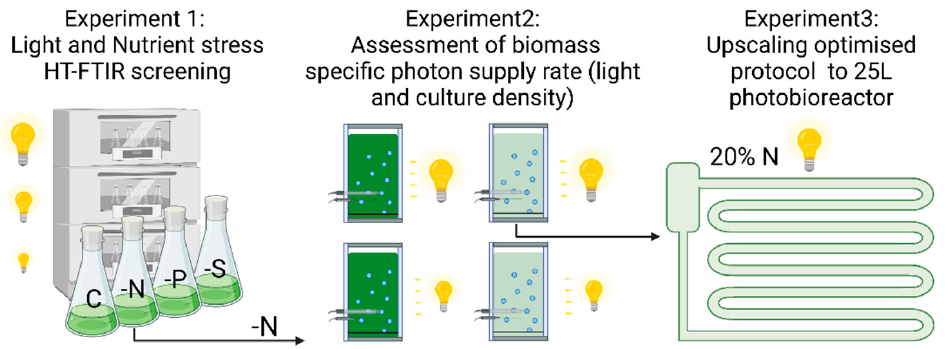
Figure 1. Experimental setup of the three experiments performed in the study. In experiment 1, FTIR spectroscopy screening, a Multitron Incubator with three cham- bers (InforsHT, Mainz, Germany) was used to test different cultivation conditions in 36 cultures. The experiment was performed in 1 L Erlenmeyer flasks containing 500 mL culture, mixed by filter-sterilised air with 1% CO 2 and orbital shaking at 110 rpm, and the light was provided from two sides. Twelve cultures with a starting Absorbance 750 nm = 1.2 were cultured for acclimation in full M8a medium, increasing light intensity from 100 to 400 µ mol m − 2 s − 1 . The starting pH was 7.5. After incubating for six days cultures were centrifuged and resuspended in 36 Erlenmeyer flasks at an Abs 750 nm = 0.5 in four medium treatments (control (C), nitrogen starved (-N), phosphorous starved (-P) and sulphur starved(-S) in triplicates. The temperature was set to 25 ◦ C and the three incubator chambers were set respectively at 800, 1300 and 1800 µ mol m − 2 s − 1 . tors [49] to study the effect of light intensity and culture density on the production of starch. The reactors’ volume capacity was 1.5 L and the light path 3 cm. The light was supplied by modulable LED panels, 5% CO 2 : air mixture ( v / v ) was supplied on demand to maintain pH stable at 7.5 ± 0.1 and the temperature was set at 25 ◦ C. Cultures were acclimated for four days, increasing light intensity daily from 100 to 500 µ mol m − 2 s − 1 . The cultures were harvested and centrifuged, and the algae were resuspended in a nitrogen starvation medium at the desired density and aliquoted into six reactors. Two inoculation densities, 0.25 and 0.65 g L − 1 were tested at two light intensities, 1300 and 1800 µ mol m − 2 s − 1 . Each treatment combination was run three